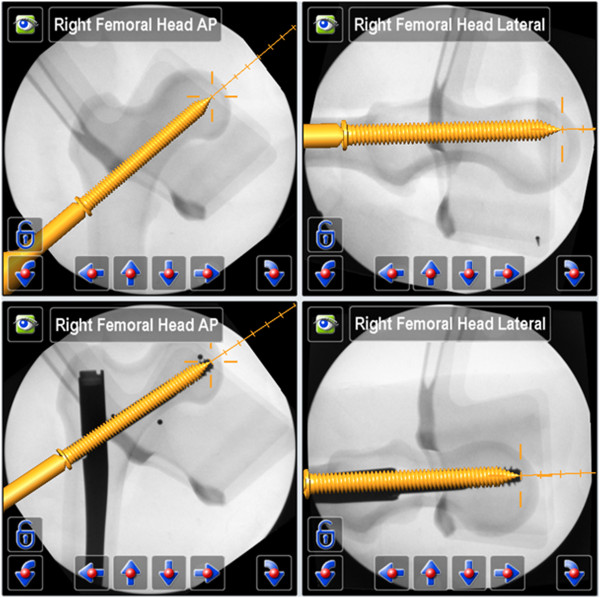
Navigation step 4 → Insertion of a femoral neck screw (above), virtual projection with the femoral neck screw (below).